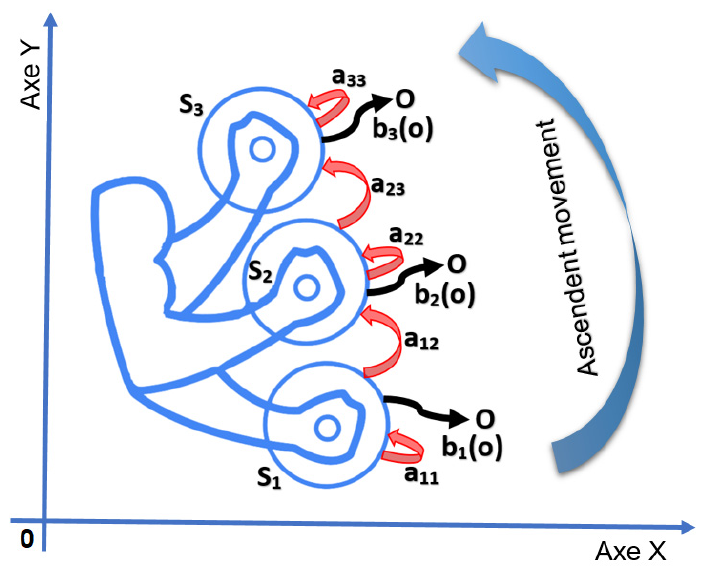
Figure 3. Relation between bi-dimensional positions during movement with Markovian modeling in the upward phase of the exercise.